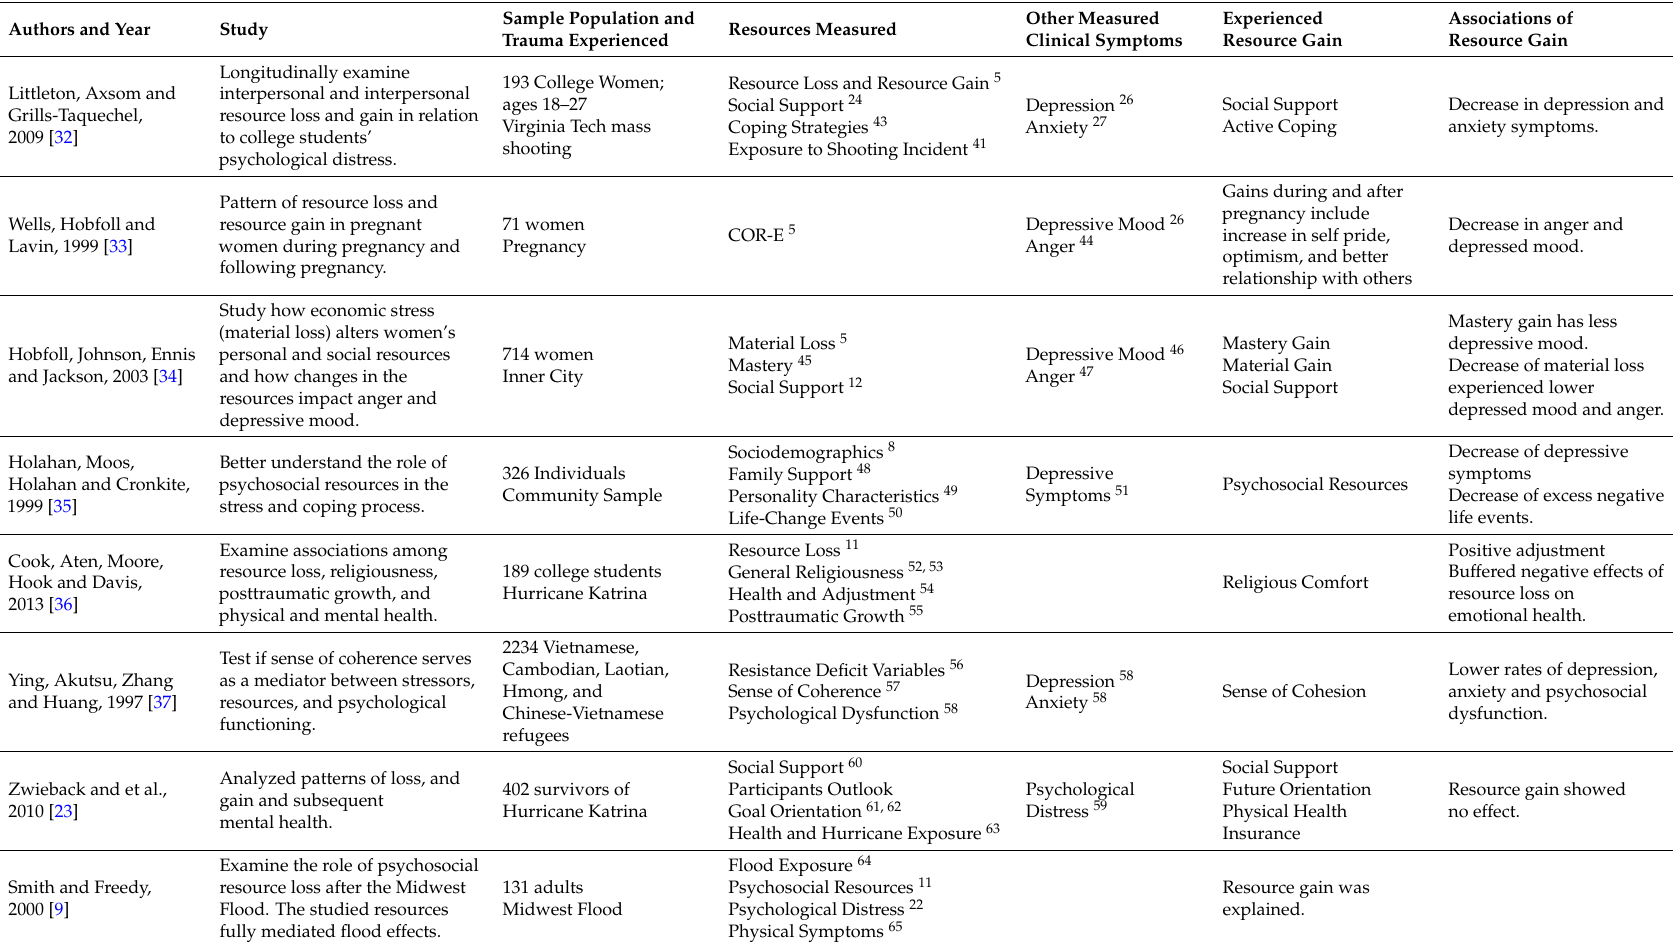
Table 2. Association Studies without PTSD Focus, Summary